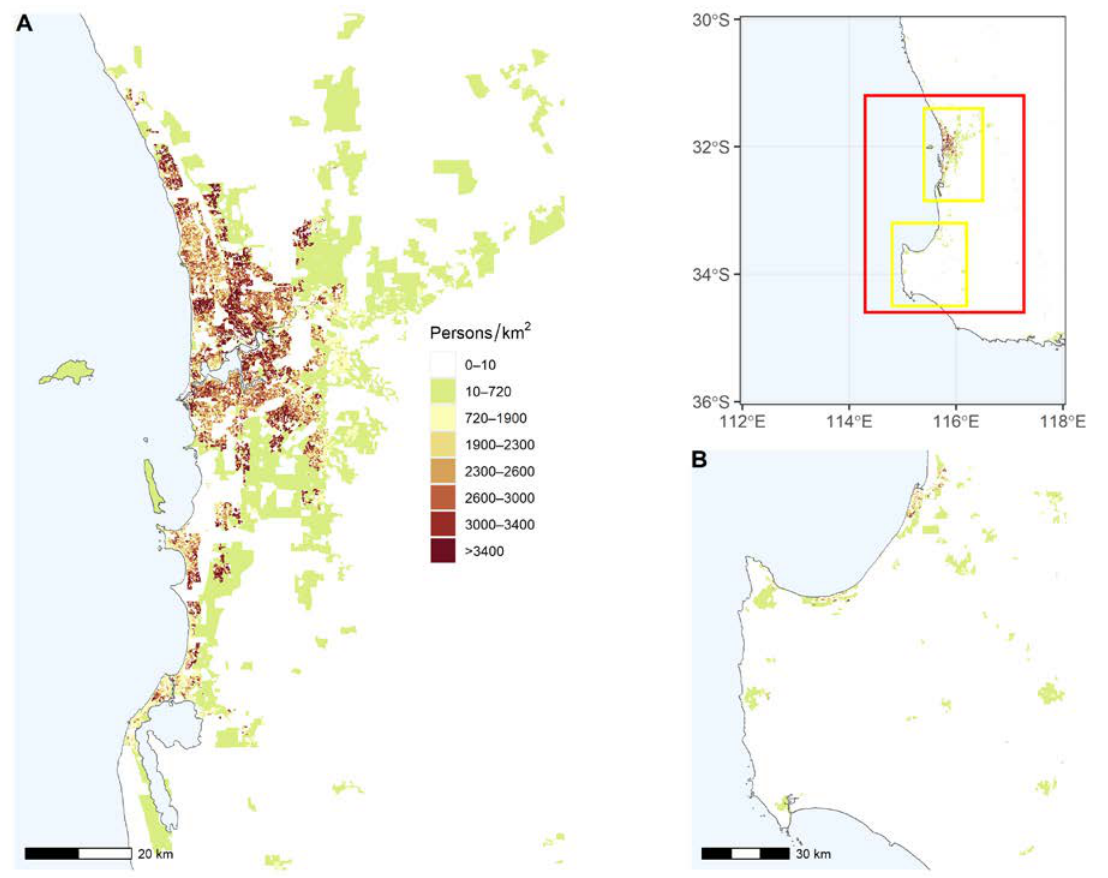
Figure 1. Study area and population. Map on top right shows the study region within the red rectangle and two sub-regions enclosed within yellow rectangles. Map on left shows population density for the city of Perth region (panel A ) and map on lower right shows the population density for the southwest of the study area ( B ).